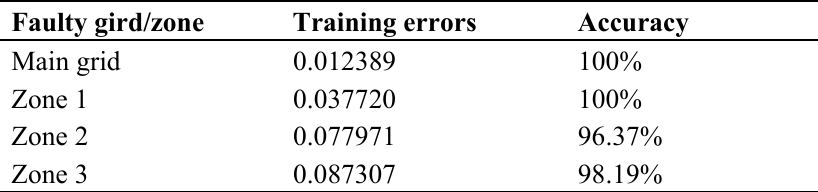
Table 1. Accuracy of proposed